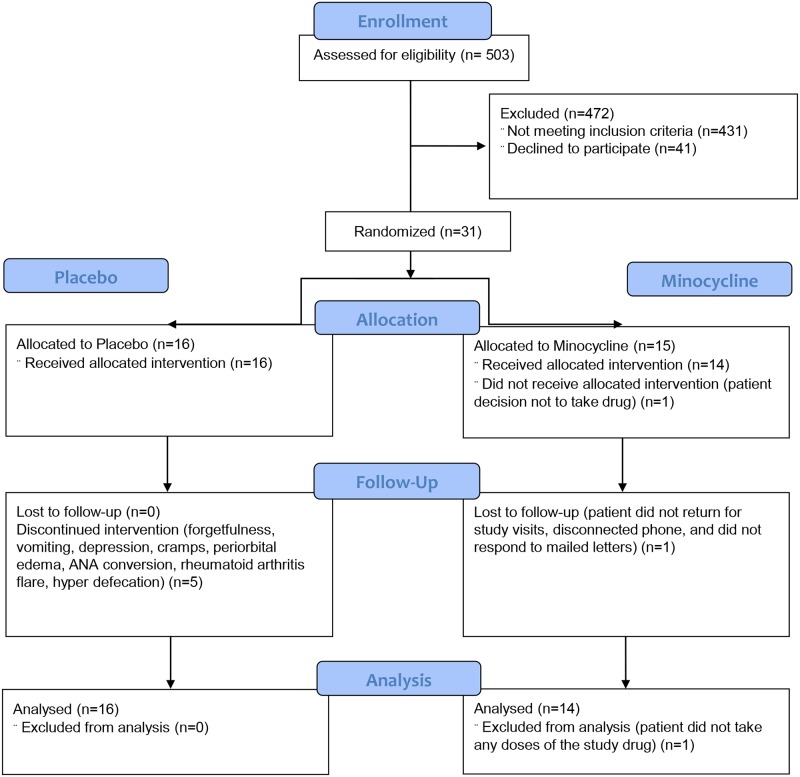
Enrollment of subjects.